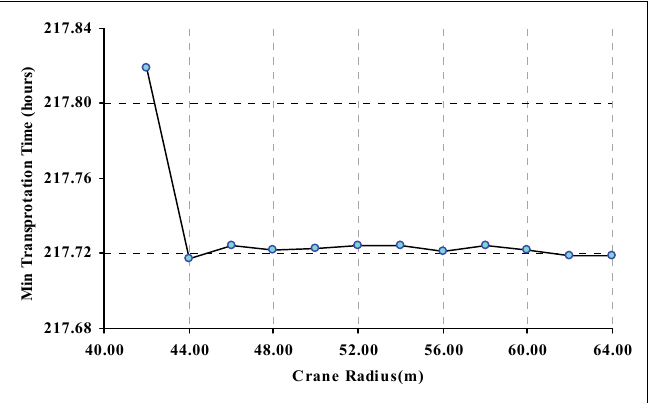
Fig. 6. Relation between transportation time and crane of